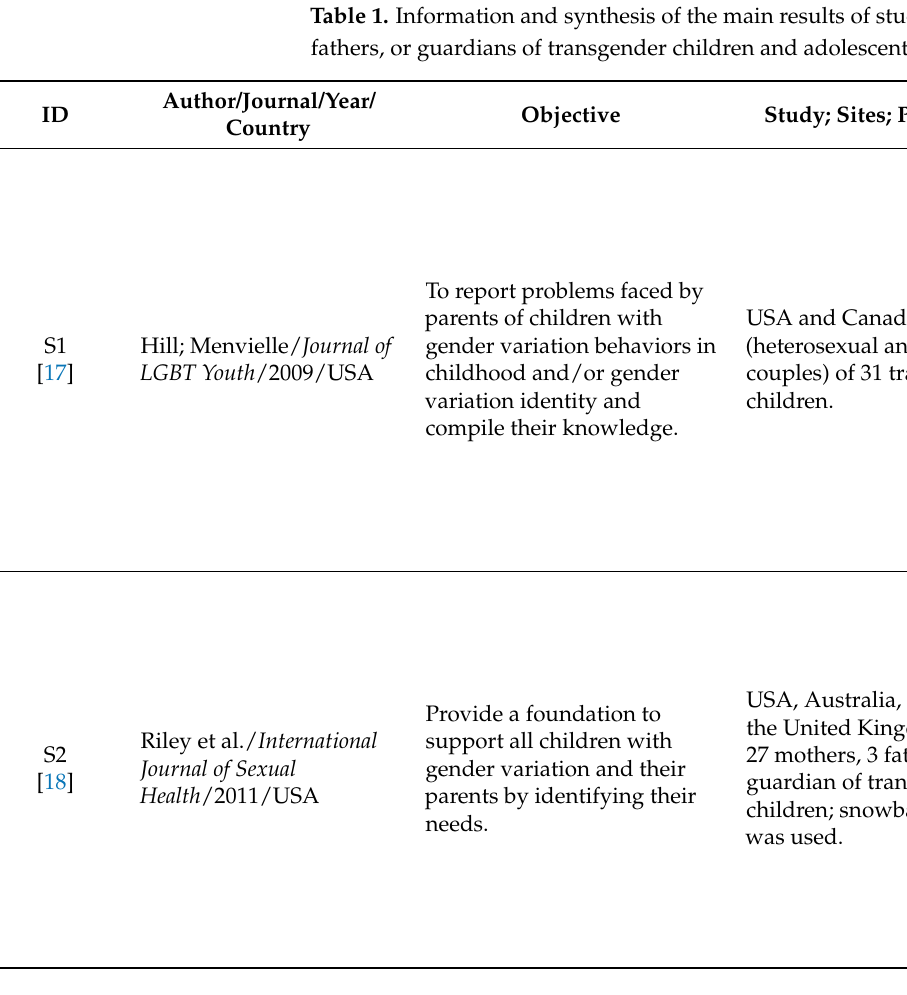
Table 1. Information and synthesis of the main results of studies selected for systematic review on the dynamics of secondary social networks to support